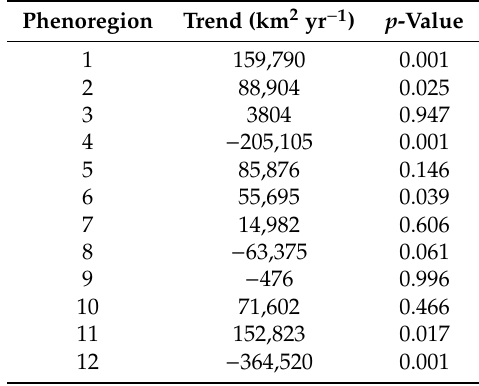
Figure 8. Annual percentage of global land area assigned to each phenoregion during the study period (2007–2015). Trends in global land area for each phenoregion are shown in Table 1. Table 1. Linear trends in global land area (km 2 year − 1 ) assigned to each Level I phenoregion during the study period (2007–2015).